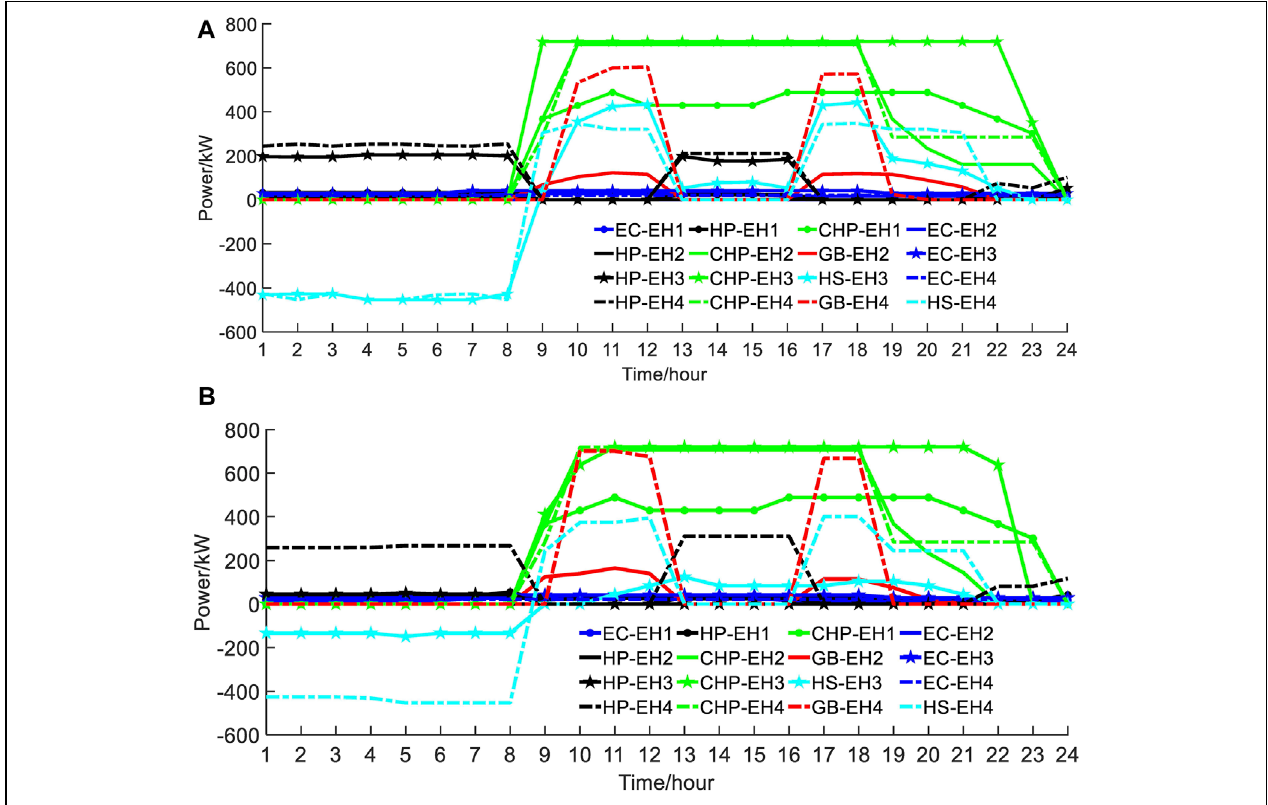
FIGURE 10 | Energy input of each equipment. (A) Energy input of each equipment in scenario A. (B) Energy input of each equipment in scenario